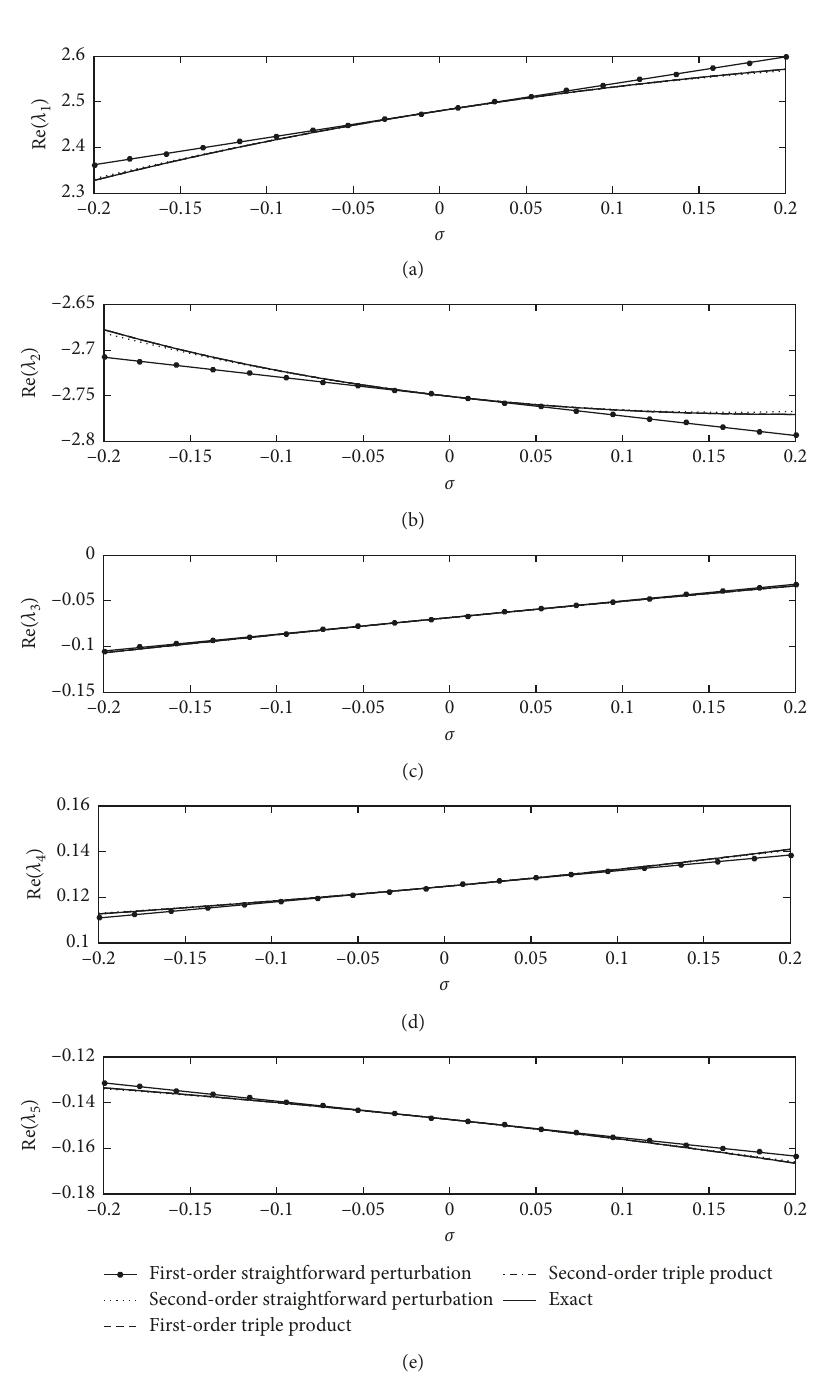
Figure 12: The real parts of the exact and approximate eigenvalues of the whirling beam as a function of σ